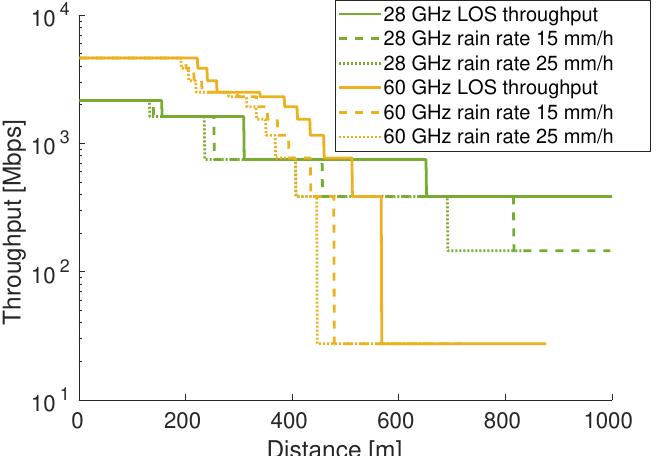
Figure 3. Maximum throughput as a function of distance for outdoor wireless networks at 28 GHz and 60 GHz.